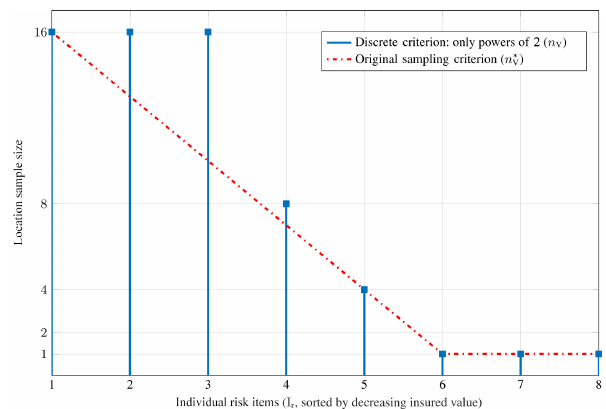
Figure 11. Criterion III: number of samples per zone depending on the insured values of the risk items. The discrete realization of the criterion (limited to powers of 2) is shown in blue, while the red line represents the theoretical linear